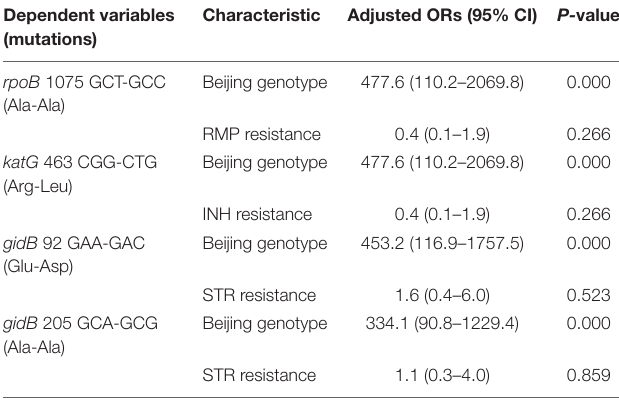
TABLE 2 | Multivariate analysis of drug resistance and genotypes of M. tuberculosis according to the four mutations. Dependent variables